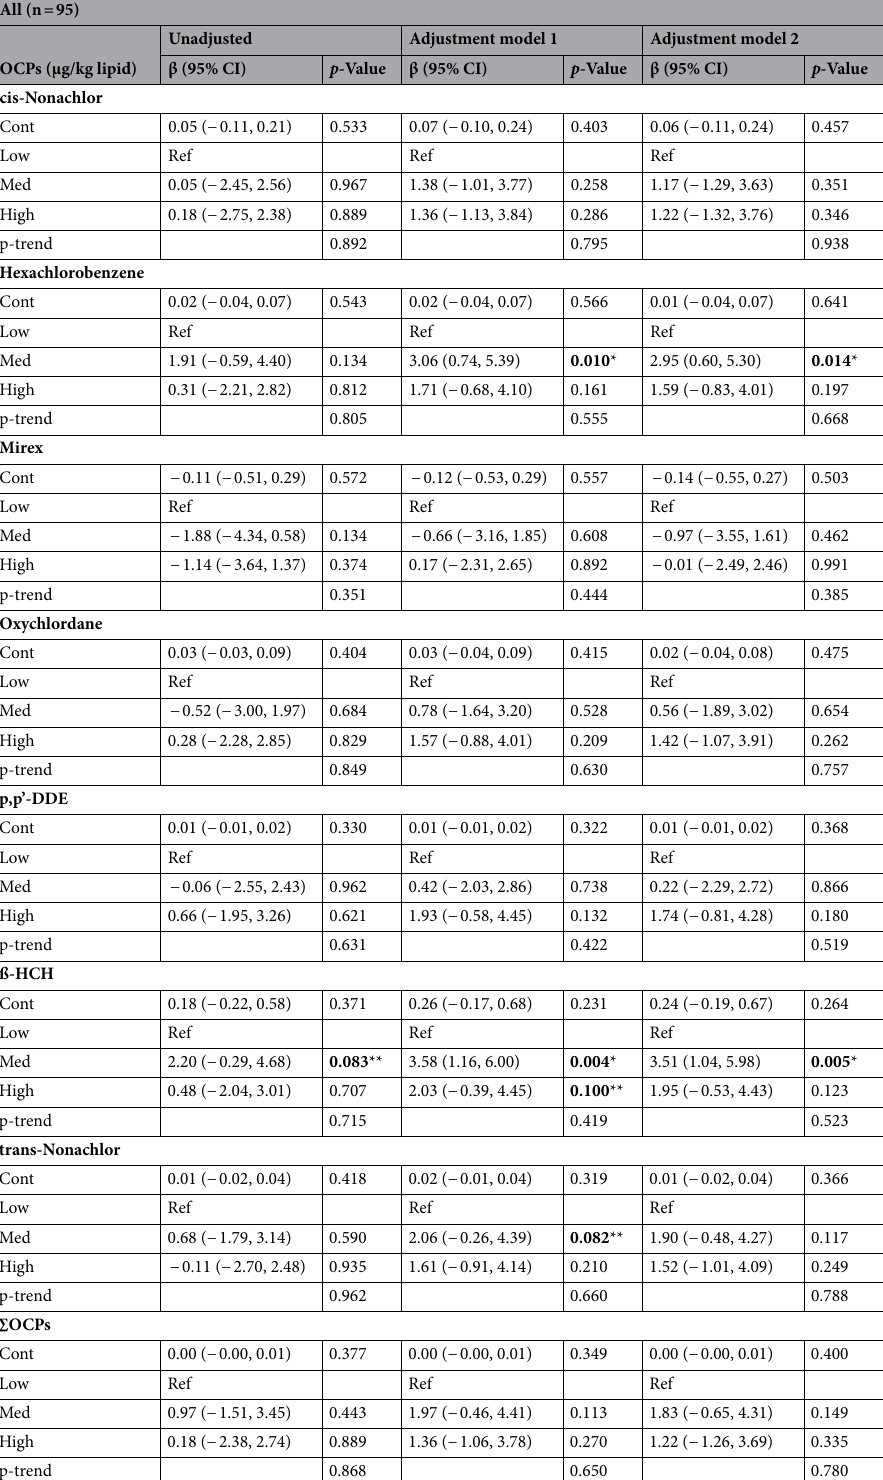
Table 4. Linear regression analysis of associations between prenatal OCP exposure and continuous SDQ score: Greenlandic children 3–5 years of age born 2014–2016 in the ACCEPT birth cohort. n Number of participants in parameter, β Linear regression coefficient in score points, CI confidence interval, Bold text and * = Significant ( p ≤ 0.050), Bold text and ** = Borderline significant ( p ≤ 0.100), Adjustment model 1: